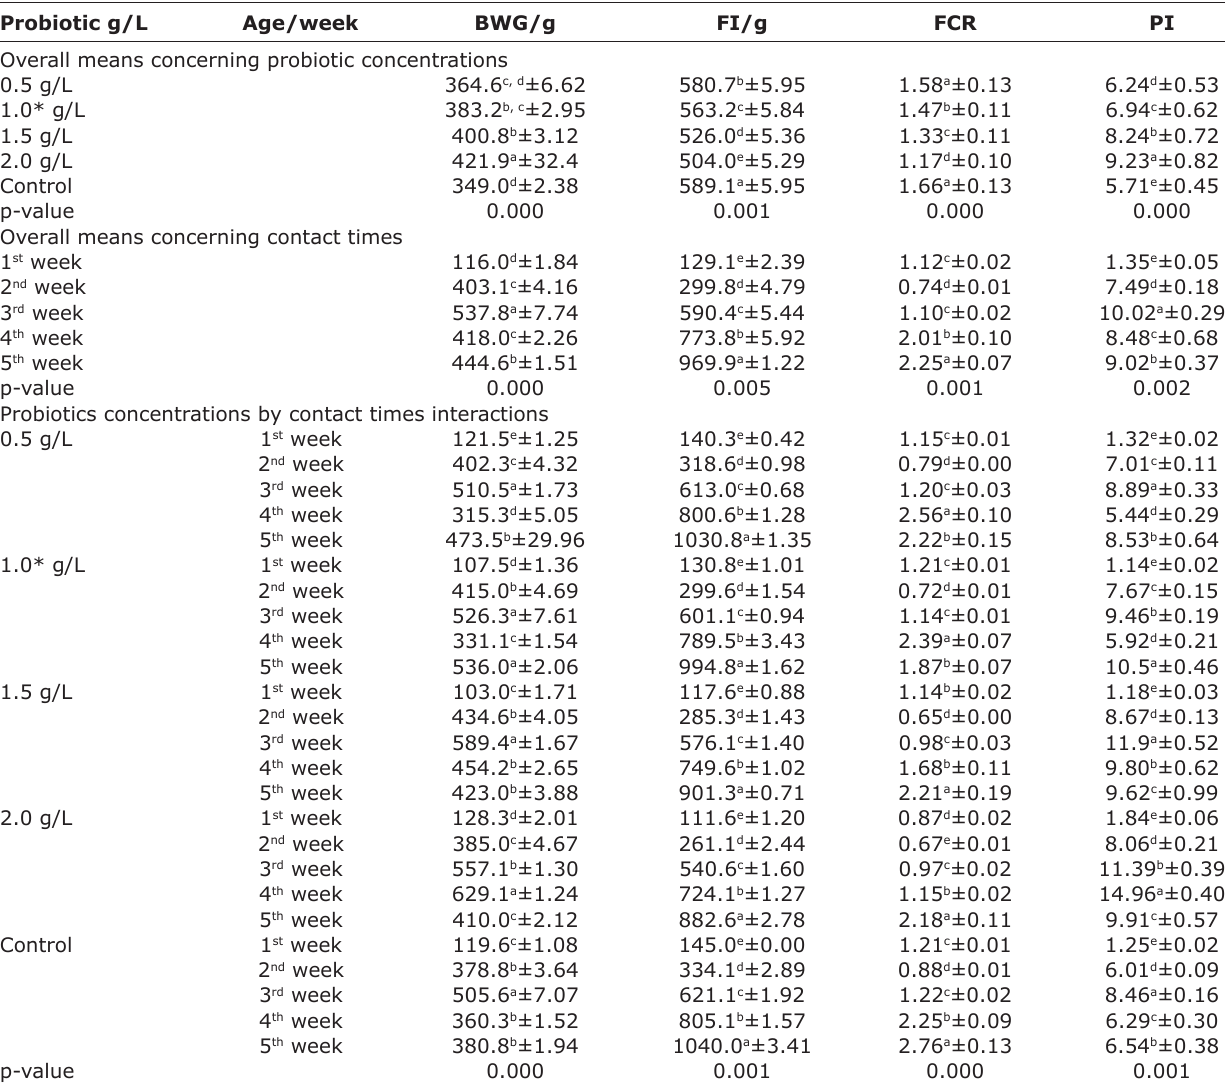
Table-2: Performance indices (mean±SE) in broilers supplemented with different concentrations of probiotics. Probiotic